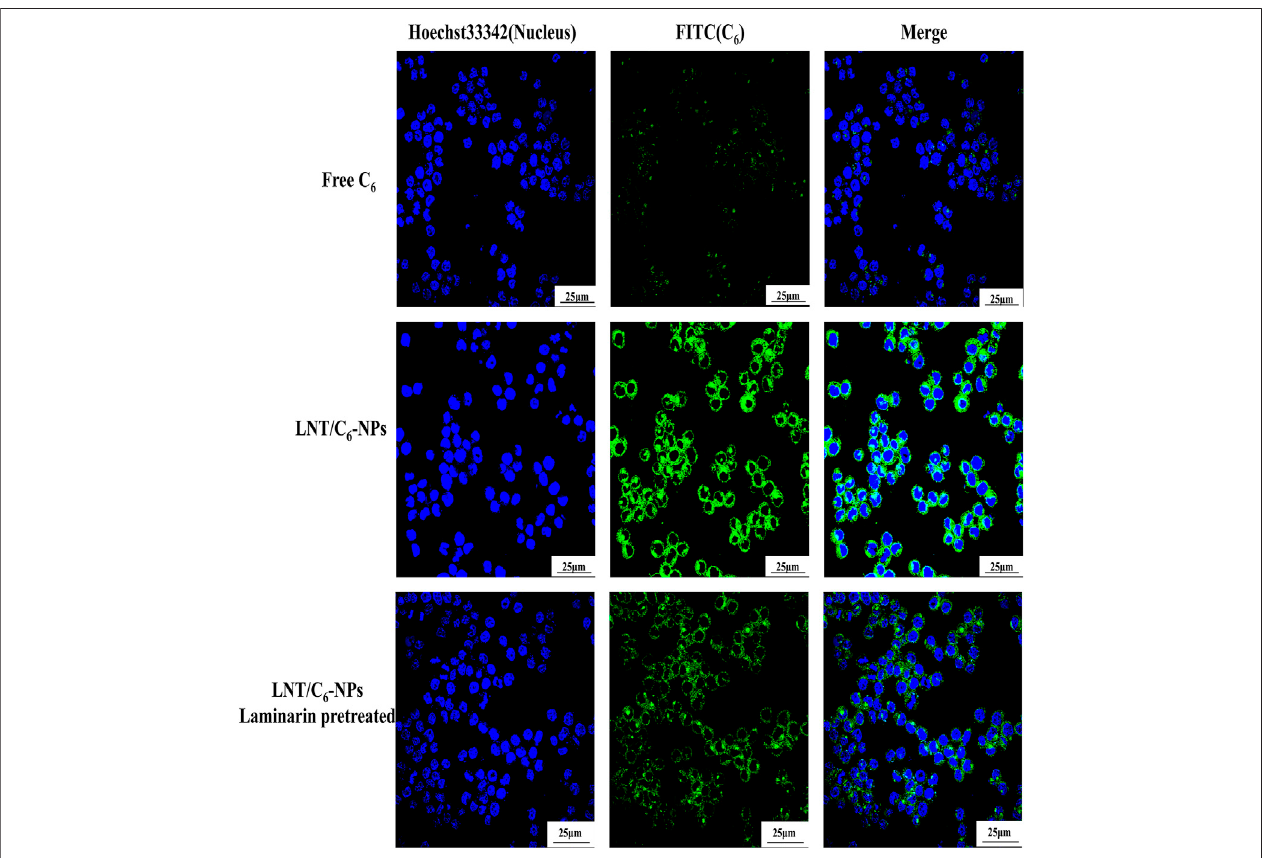
FIGURE 2 | Qualitative analysis of macrophage cellular uptake capacity to Free C 6 and LNT/C 6 -NPs.